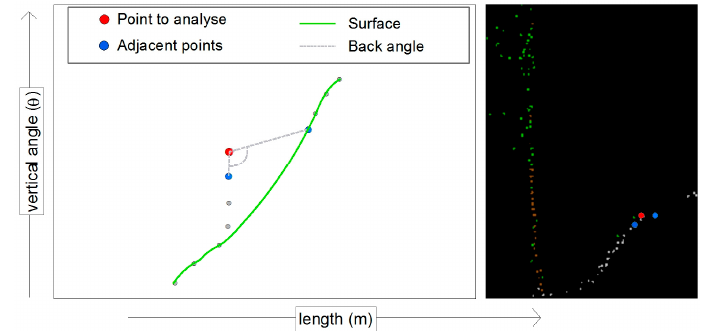
Figure 5. Terrain view from the side with vegetation points.